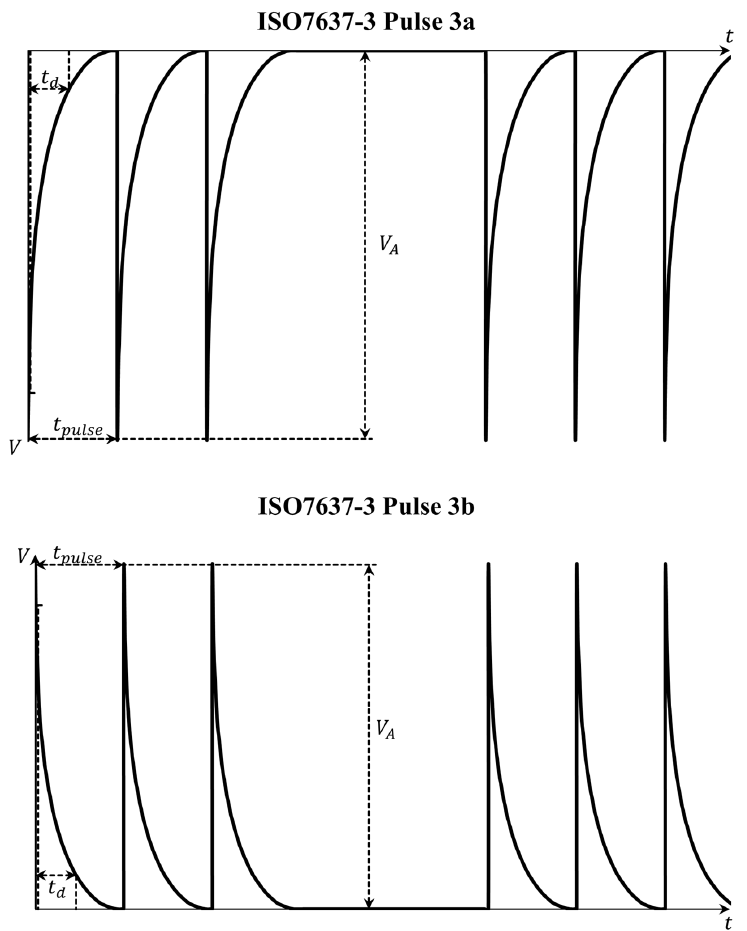
Figure 6. ISO 7637-3 pulses: waveform pulse 3a and pulse 3b (negative and positive transient Figure 6. ISO 7637 ‐ 3 pulses: waveform pulse 3a and pulse 3b (negative and positive transient volt ‐ age).